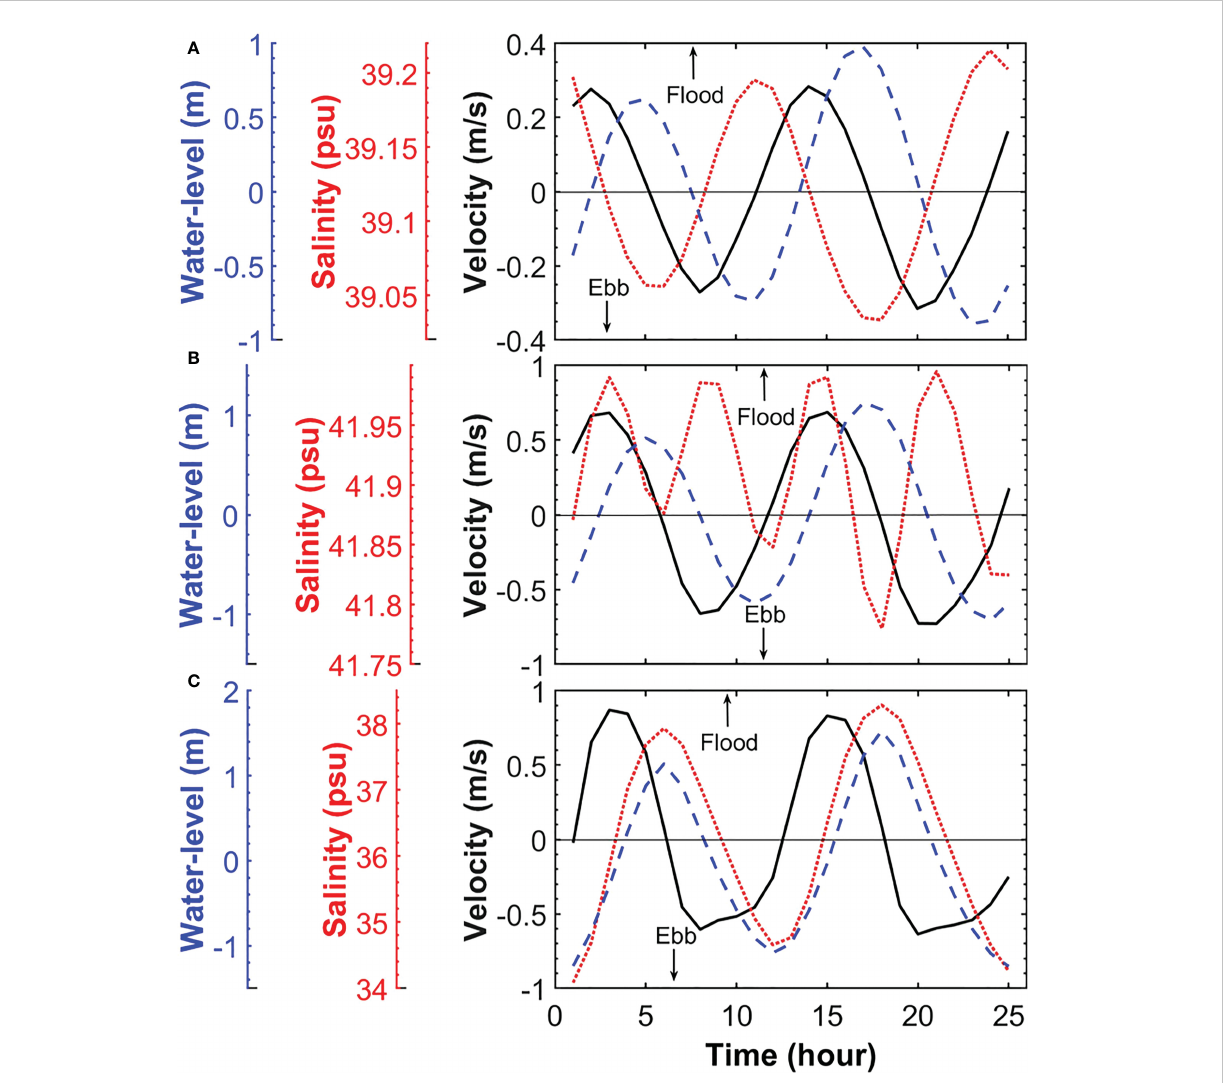
FIGURE 10 Tidal variations in depth-mean axial velocity (the thick black line), salinity (the dotted red line) and water-level (the dashed blue line) on the main channel axis at ~20 km (A) , ~ 48 km (B) and ~ 80 km (C) in EXP11 during 25